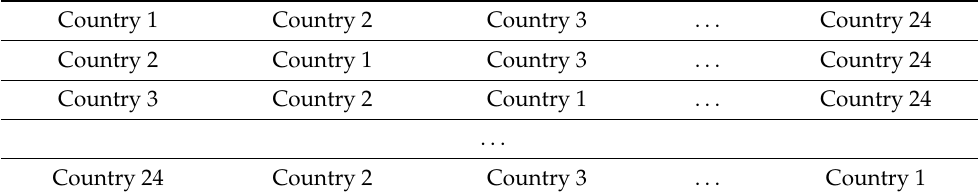
Table 3. Analysis of characteristics of country units by Tabu search. Country 1 Country